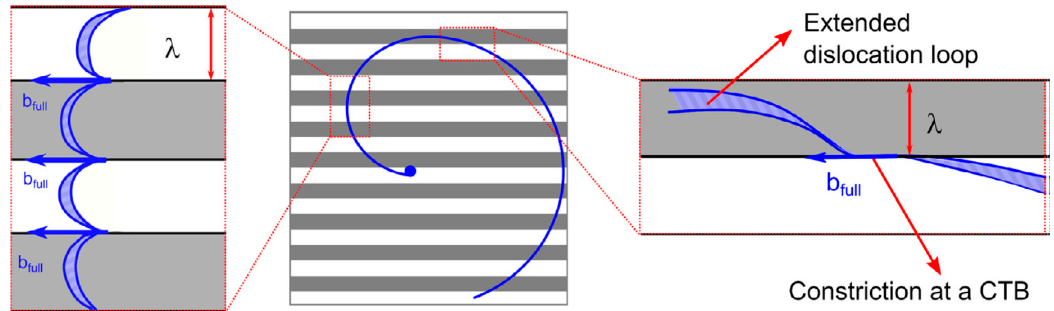
Figure 19. Schematic of the local curvature of partial dislocations between two adjacent coherent twin boundaries during dislocation transmission by the cross-slip mode. (Reprinted from Reference [18], with permission from Elsevier).